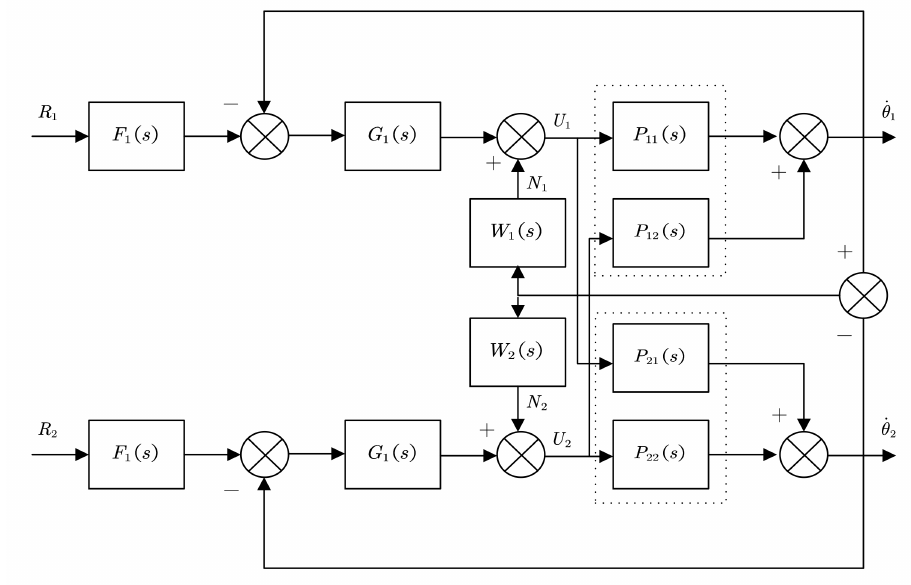
Figure 2. Block Diagram of Cross-coupled